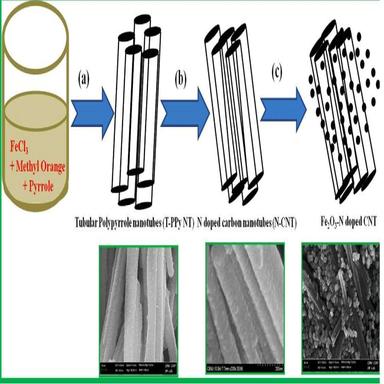
Schematic representation of Fe2O3/N-CNT.